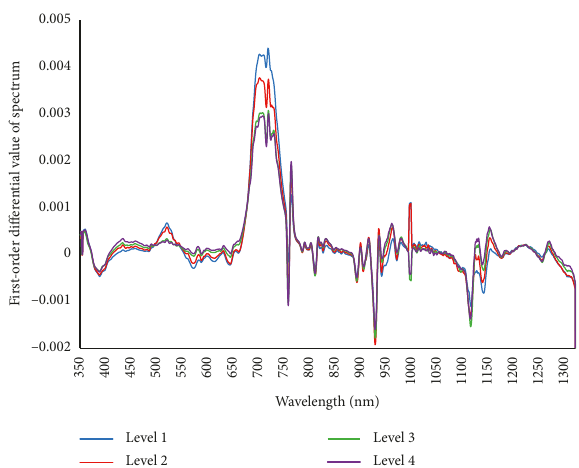
Figure 5: The first-order spectral differential curves of different disease severities (350 ∼ 1330nm).